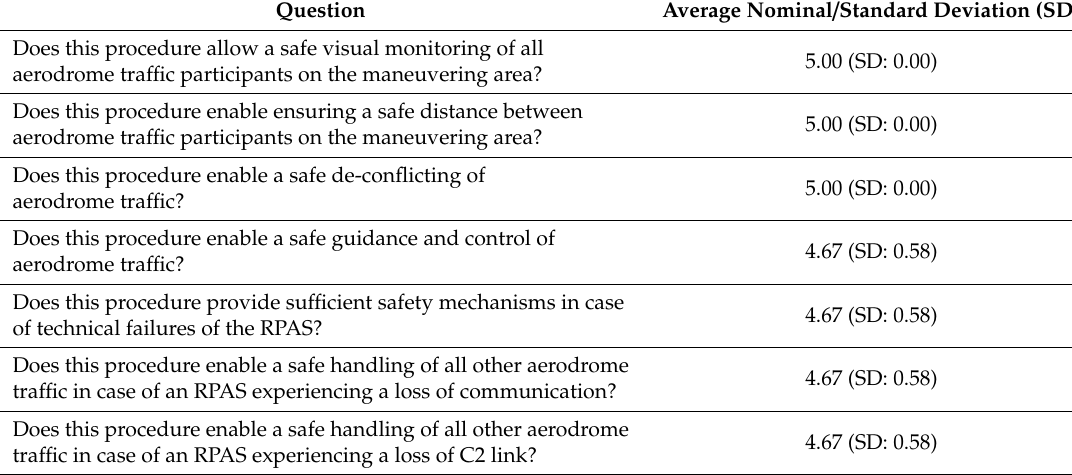
Table 2. Results of tailor-made questionnaires related to safety in non-nominal situations (loss of command and control link, and loss of communication), answered by ATCOs.